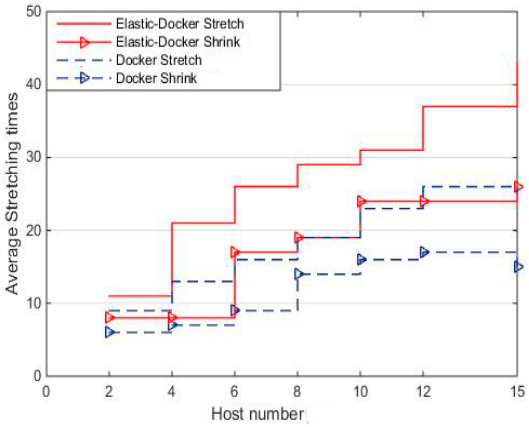
Figure 13. Comparison of scalability.